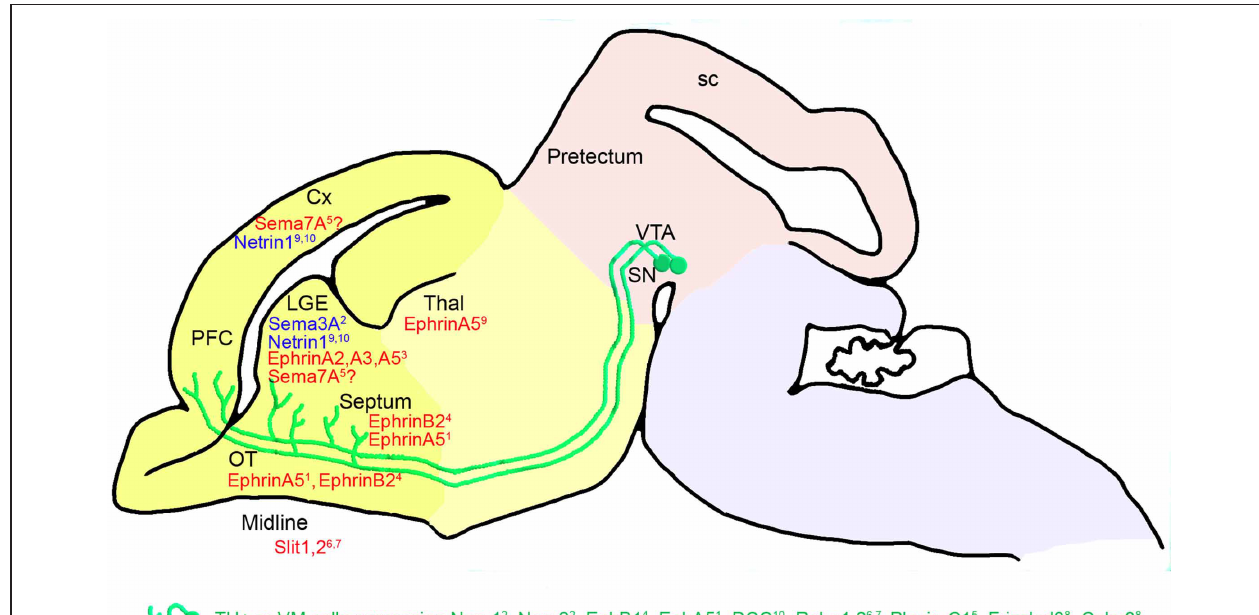
FIGURE 3 | Telencephalic guidance: expression of repulsive (in red) and attractive (in blue) guidance cues in the environment of mDA somas and axons between E14.5 and E18.5 in mice. mDA axons (in green) connect to the telencephalic regions through specific receptors (in green). The expression of these receptors has been detected in the mDA cells in the VM using double immunostaining against TH and protein receptors. Receptors expressed in all or most of the midbrain TH-expressing (TH + ) cells are underlined, whereas receptors expressed in a small fraction of TH-expressing cells are not. EphB1 has been detected at the mRNA level in